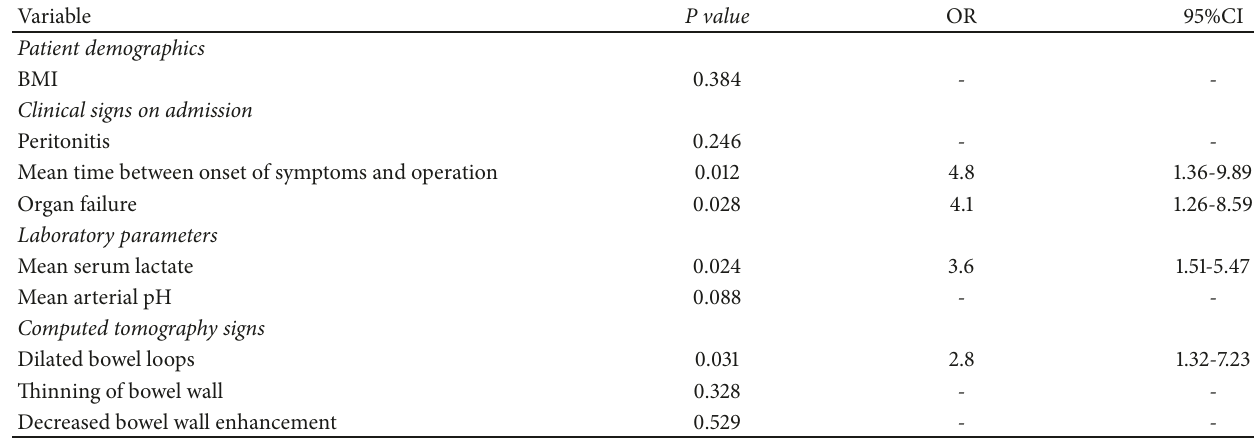
Table 3: Risk factors associated with intestinal necrosis in mesenteric vascular thrombosis on logistic regression analysis.